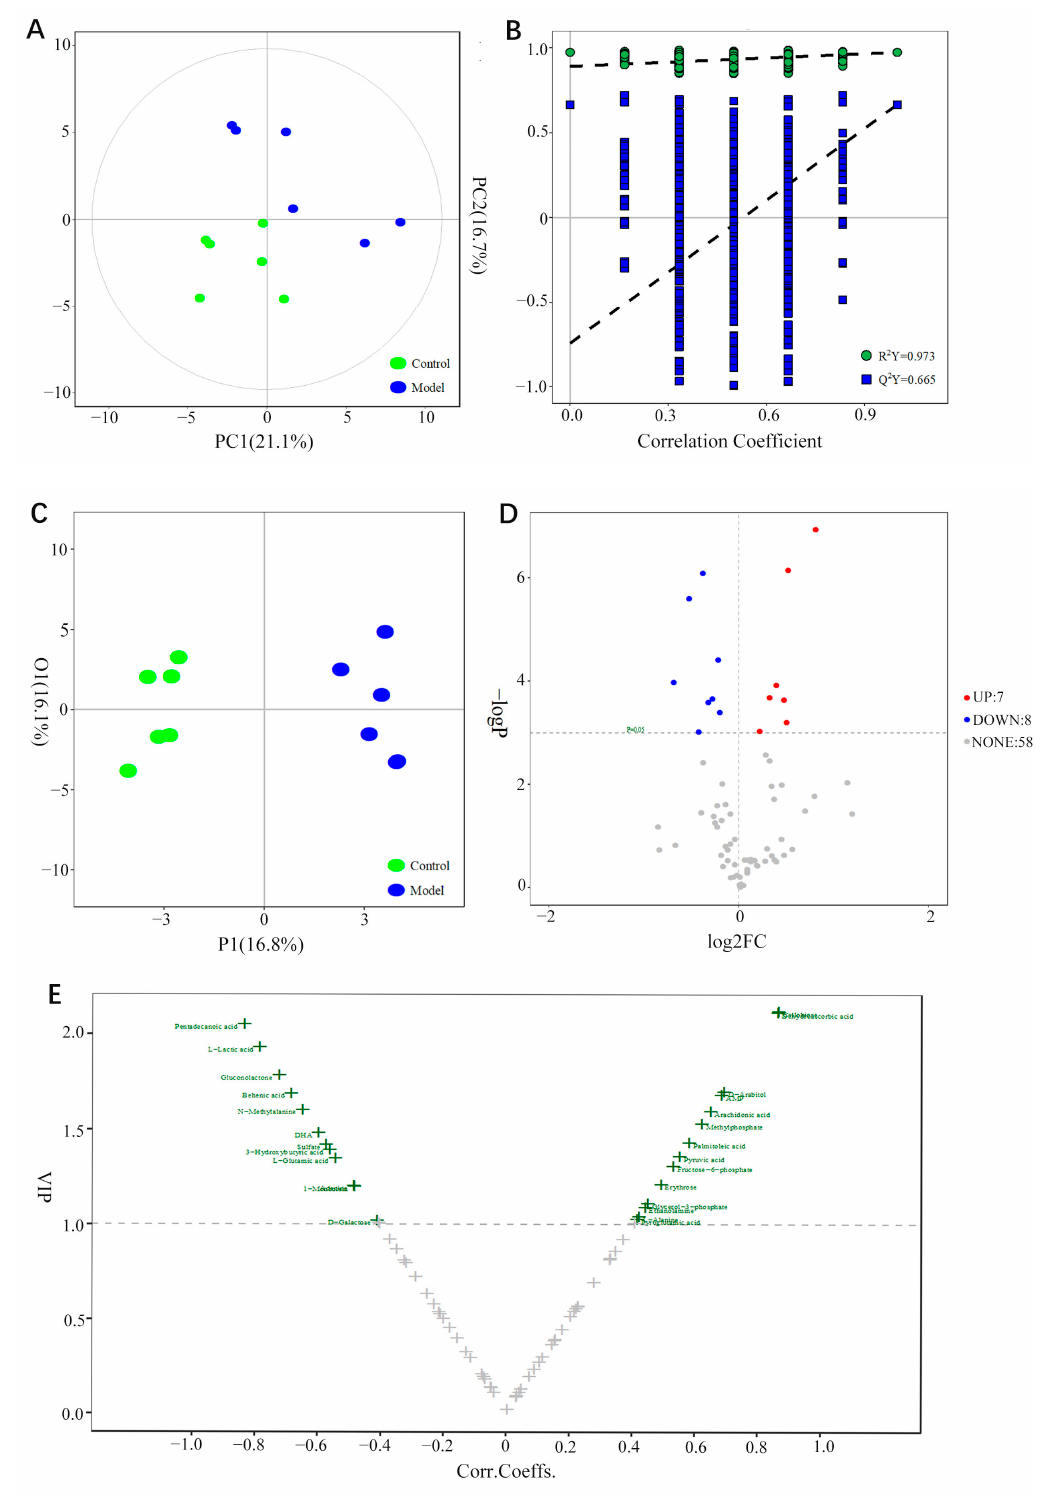
Figure 6. Potential biomarkers in rat hippocampus screened by univariate and multivariate statistical analyses. ( A ) PCA score plot of the control and model. ( B ) Results of permutation test. ( C ) OPLS-DA score plot of control and model. ( D ) Volcano plot of differential metabolites screened by univariate statistical analyses. ( E ) Volcano plot of differential metabolites screened by multivariate statistical analyses